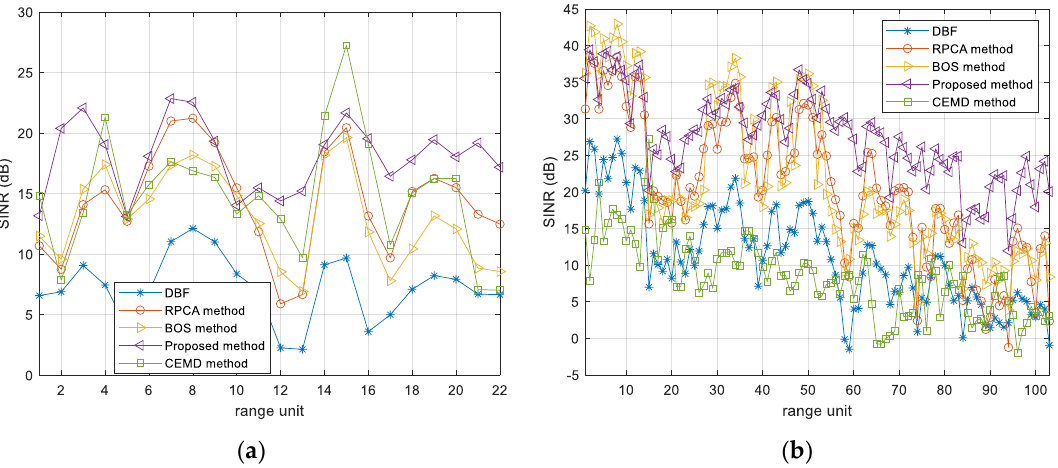
Figure 9. The SINR improvements of LCI mitigation in range domain: ( a ) Negative − frequency sea echo of the LCI; ( b ) Positive − frequency sea echo of the LCI.